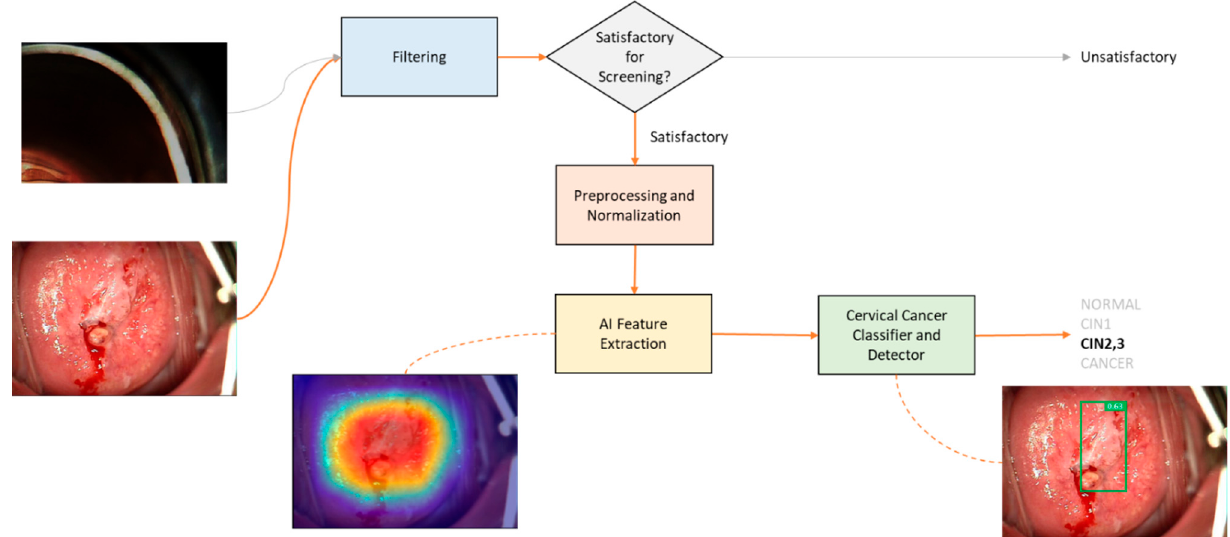
Figure 1. A diagram of Cerviray AI ® interpretation for colposcopic images. The system assesses the visibility of the images, and recognizes the squamocolumnar junction and transformation zone of the uterine cervix. If the image is satisfactory for evaluation, the image is processed and normalized for AI feature extraction. This is followed by the classification of images according to the AI impression.